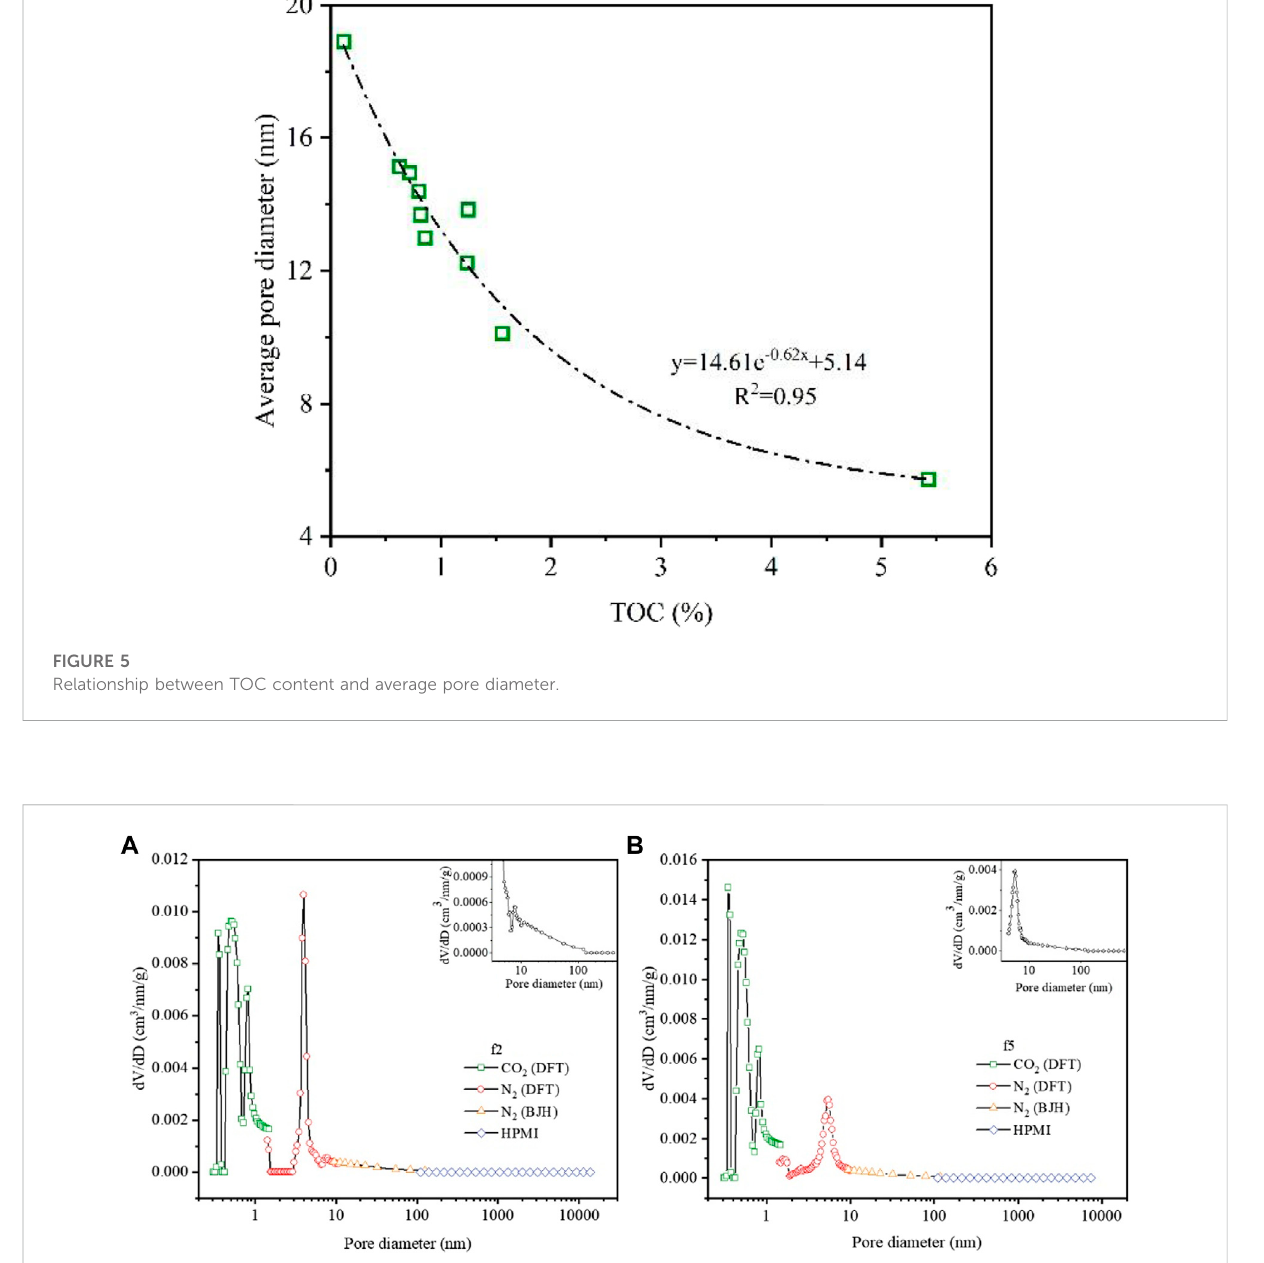
FIGURE 6 Shale pore size distribution combined with high pressure mercury intrusion, N 2 adsorption and CO 2 adsorption. Among them, the green dot pore size distribution curve is the interpretation results of CO 2 adsorption DFT model ( < 2 nm), the red dot pore size distribution curve is the interpretation results of N 2 adsorption DFT model ( < 10 nm), the yellow dot pore size distribution curve is the interpretation results of N 2 adsorption BJH model ( < 100 nm), and the blue point pore size distribution curve is the interpretation results of high pressure mercury intrusion